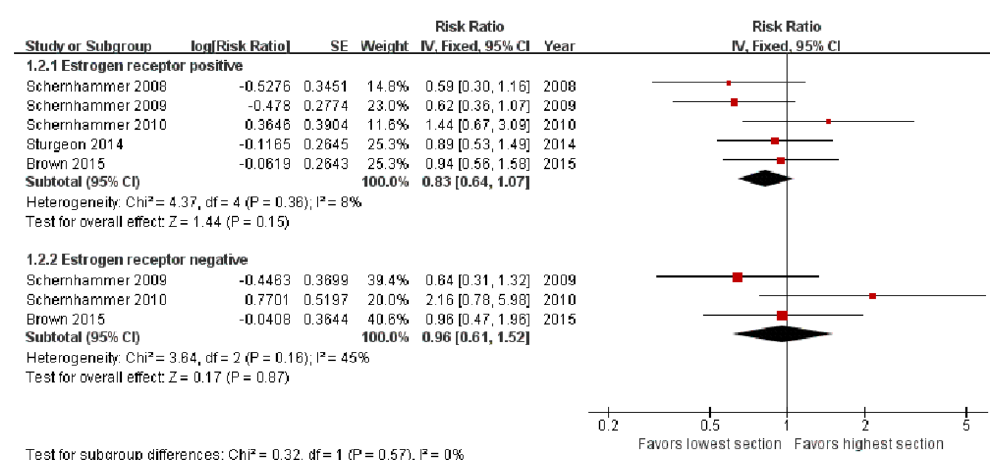
Figure 6. Forest plot for the association between urinary 6-sulfatoxymelatonin levels and estrogen receptor positive (upper sub-figure) and negative (lower sub-figure) breast cancer risk. Urinary 6-sulfatoxymelatonin is inversely associated with estrogen receptor positive breast cancer with a borderline significance, but not with estrogen receptor negative